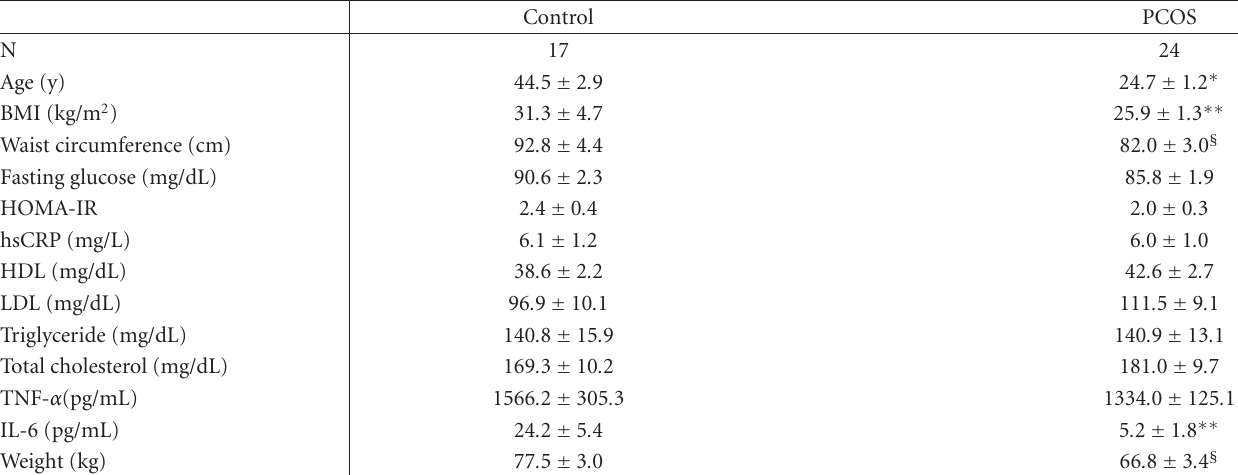
Table 3: Anthropometric and biochemical variables of patients with PCOS. Data were presented as means ± SEM (compared to control, ∗ P < . 001, ∗∗ P < . 01, § P < . 05).